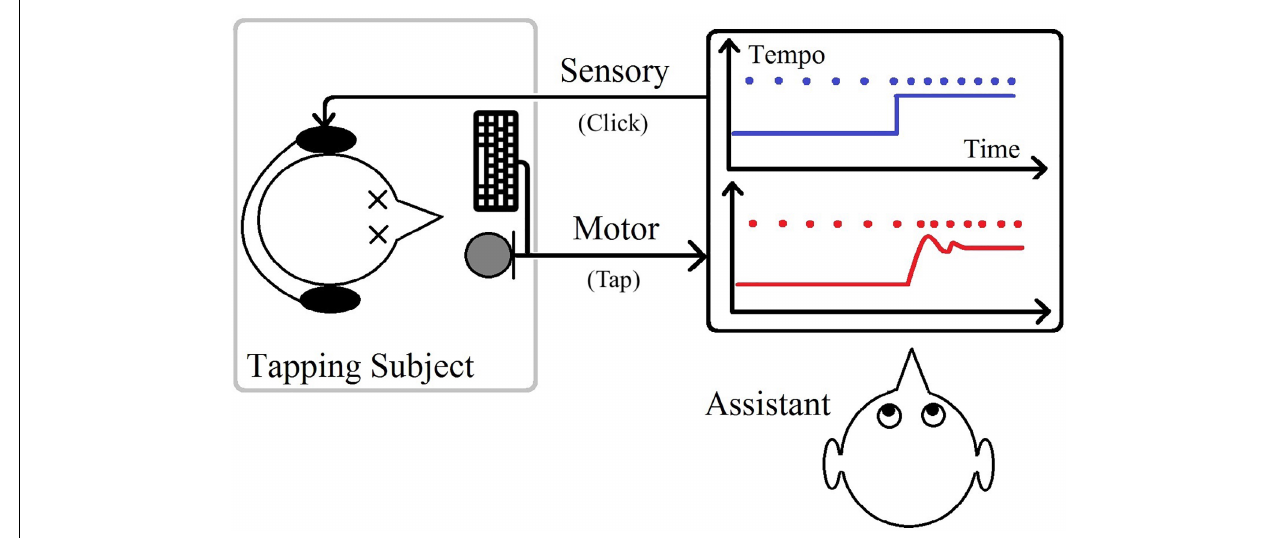
FIGURE 1 | Illustration of the sensorimotor